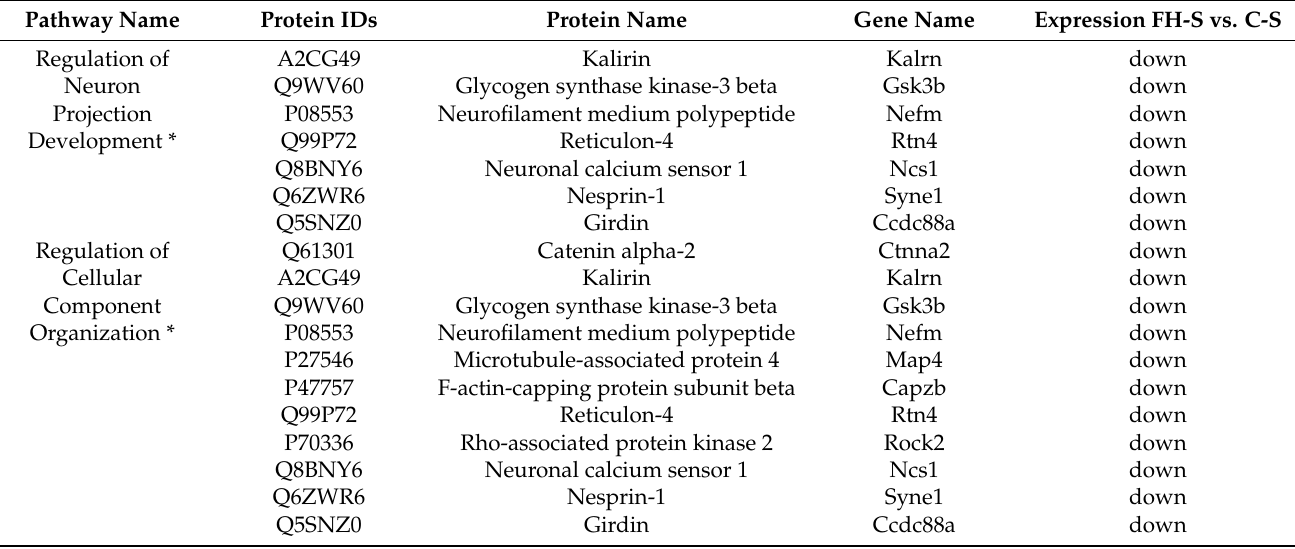
Table 5. Proteins from the neuronal network modulated by the interaction Stress ×